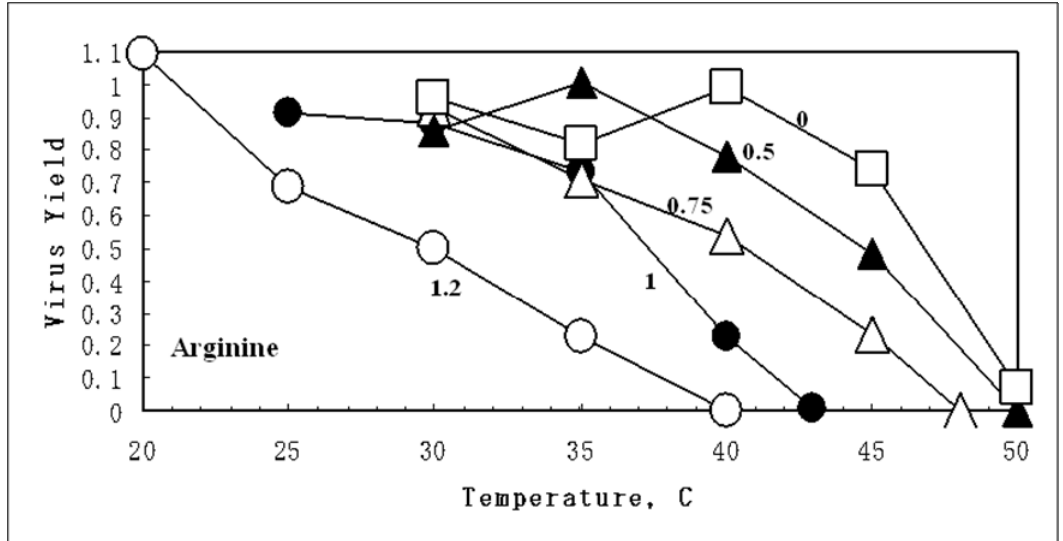
Figure 2. Inactivation of HSV-1 by arginine at neutral pH as a function of temperature.